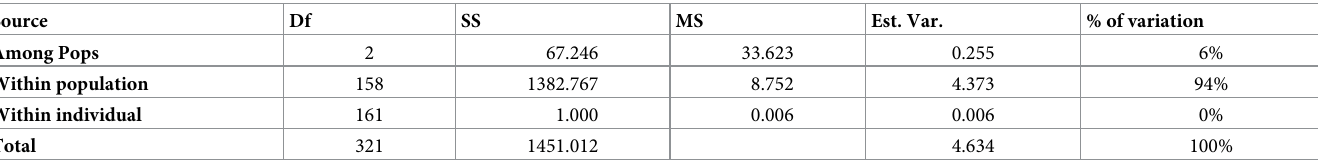
Table 5. Analysis of molecular variance (AMOVA).